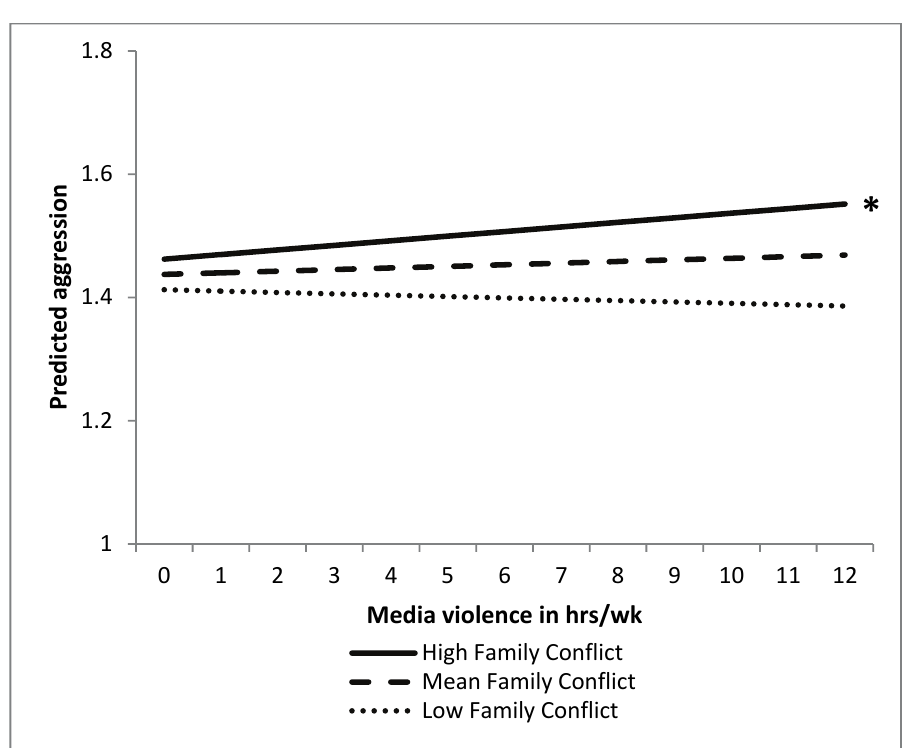
Figure 1. High media violence exposure and high family conflict lead to increased aggression in adolescents (* = significant at p < 0.05). Note: low, mean, and high family conflict represent values of 1.76, 2.10, and 2.44 on the family conflict